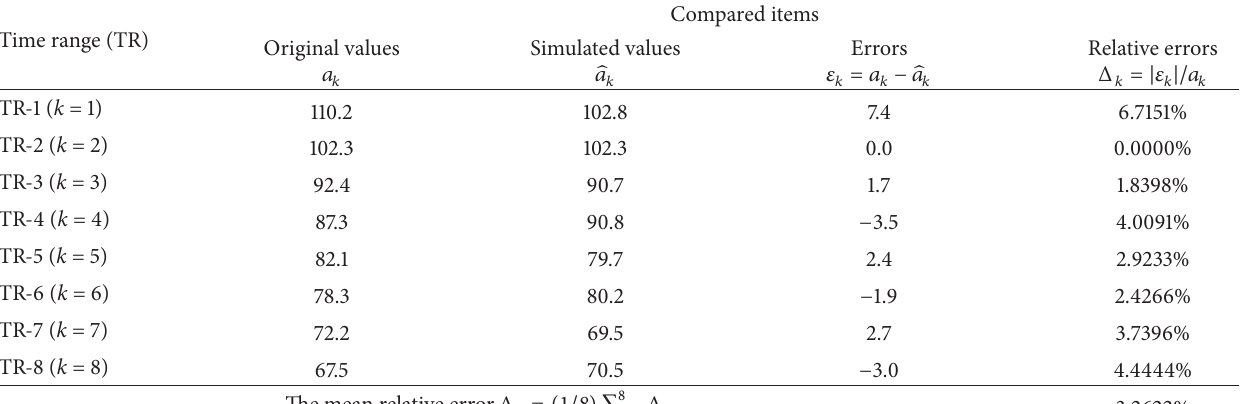
Table 2: Simulated values and errors of upper limits.